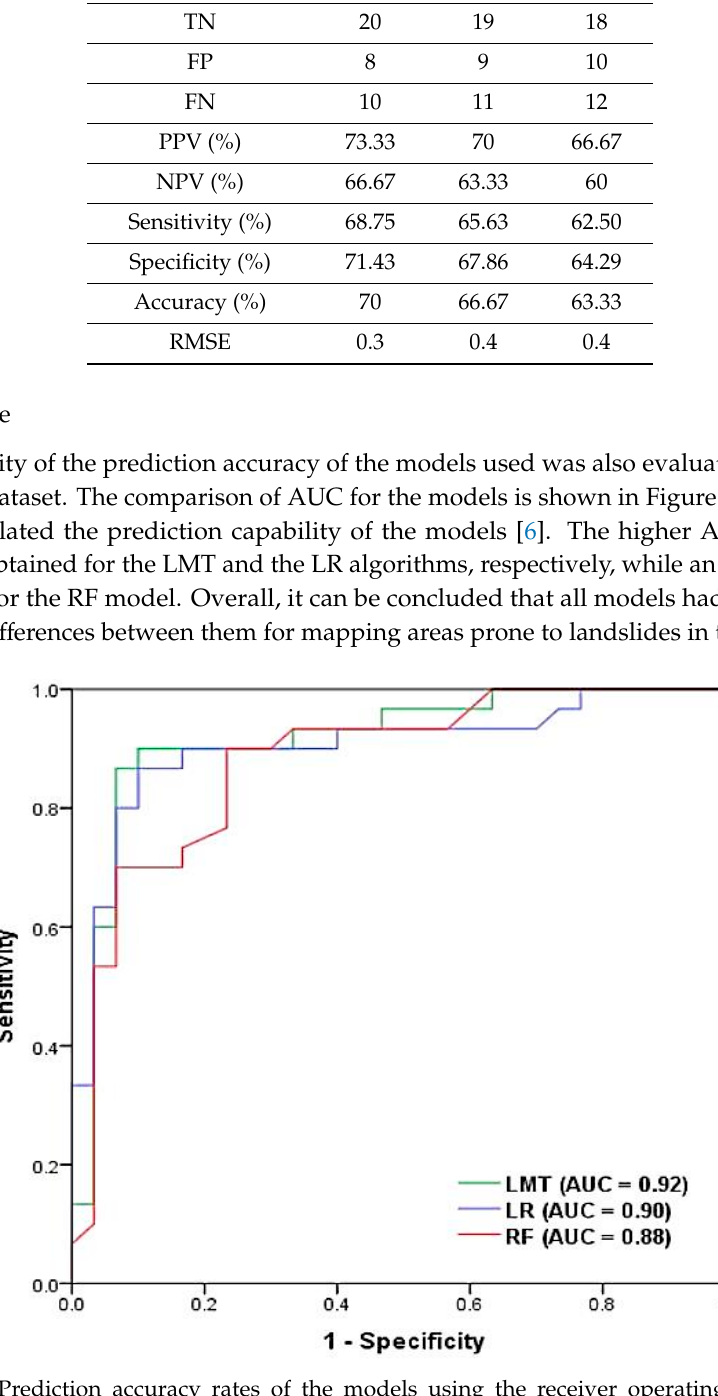
Figure 12. Prediction accuracy rates of the models using the receiver operating characteristic (ROC) curve.